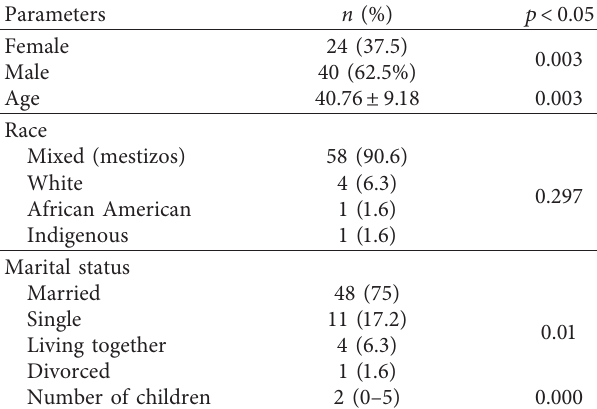
Table 1: Demographic